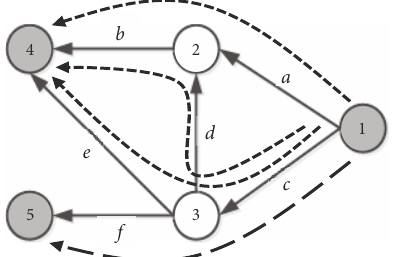
Figure 1. A hypothetical transportation network illustrating